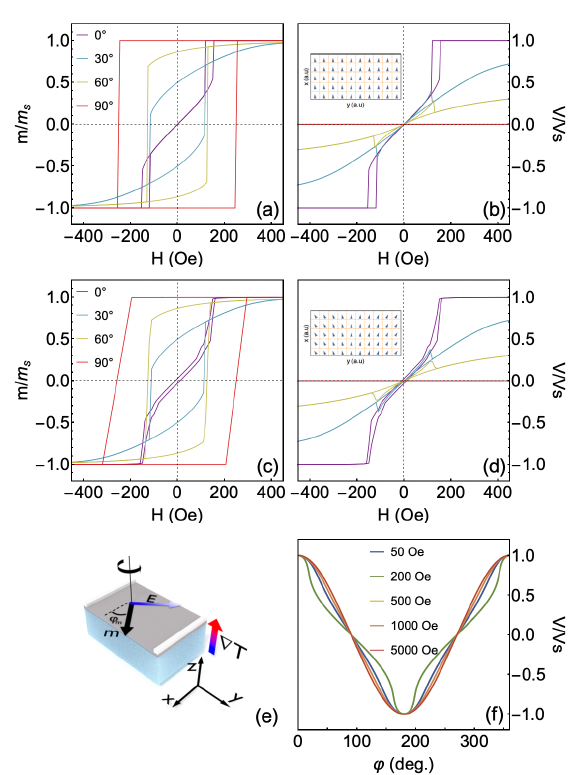
Figure 6. Numerical calculations of magnetic properties and thermoelectric voltage. ( a ) Normalized magnetization and ( b ) thermoelectric voltage curves, at selected ϕ values, for a system having induced uniaxial magnetic anisotropy and cubic magnetic anisotropy, without anisotropy dispersion. The calculations were performed with m si = m s 1 = ... = m s 50 = m s = 1330 G, k ui = k u 1 = ... = k u 50 = k u , with h k = 220 Oe and ϕ ki = ϕ k 1 = ... = ϕ k 50 = 0 ◦ , as well as k c 1 i = k c 11 = ... = k c 150 = 2.8 k u . Furthermore, we considered ∆ T = 27 K. In ( b ), the inset illustrates a simple view of magnetic domains in the system without anisotropy dispersion. ( c , d ) Similar plots for the the same system having uniaxial anisotropy dispersion, in which ϕ ki dispersed linearly around 0 ◦ , with dispersion range of ∆ ϕ k = 10 ◦ . In ( d ), the inset also brings the simple view of the magnetic domains in the system without anisotropy dispersion. ( e ) Schematic representation of our bilayer structure in the experiment, in which we depict ϕ m that is inserted in Equation (9) for the calculations. ( f ) Angular dependence of the thermoelectric voltage at ∆ T = 27 K for distinct field values for the system with anisotropy dispersion. The curves are normalized in order to make easier the direct comparison between